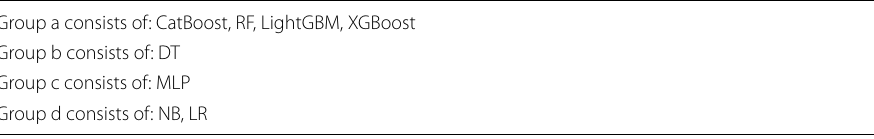
Table 28 HSD test groupings after ANOVA of AUPRC for the classifier factor